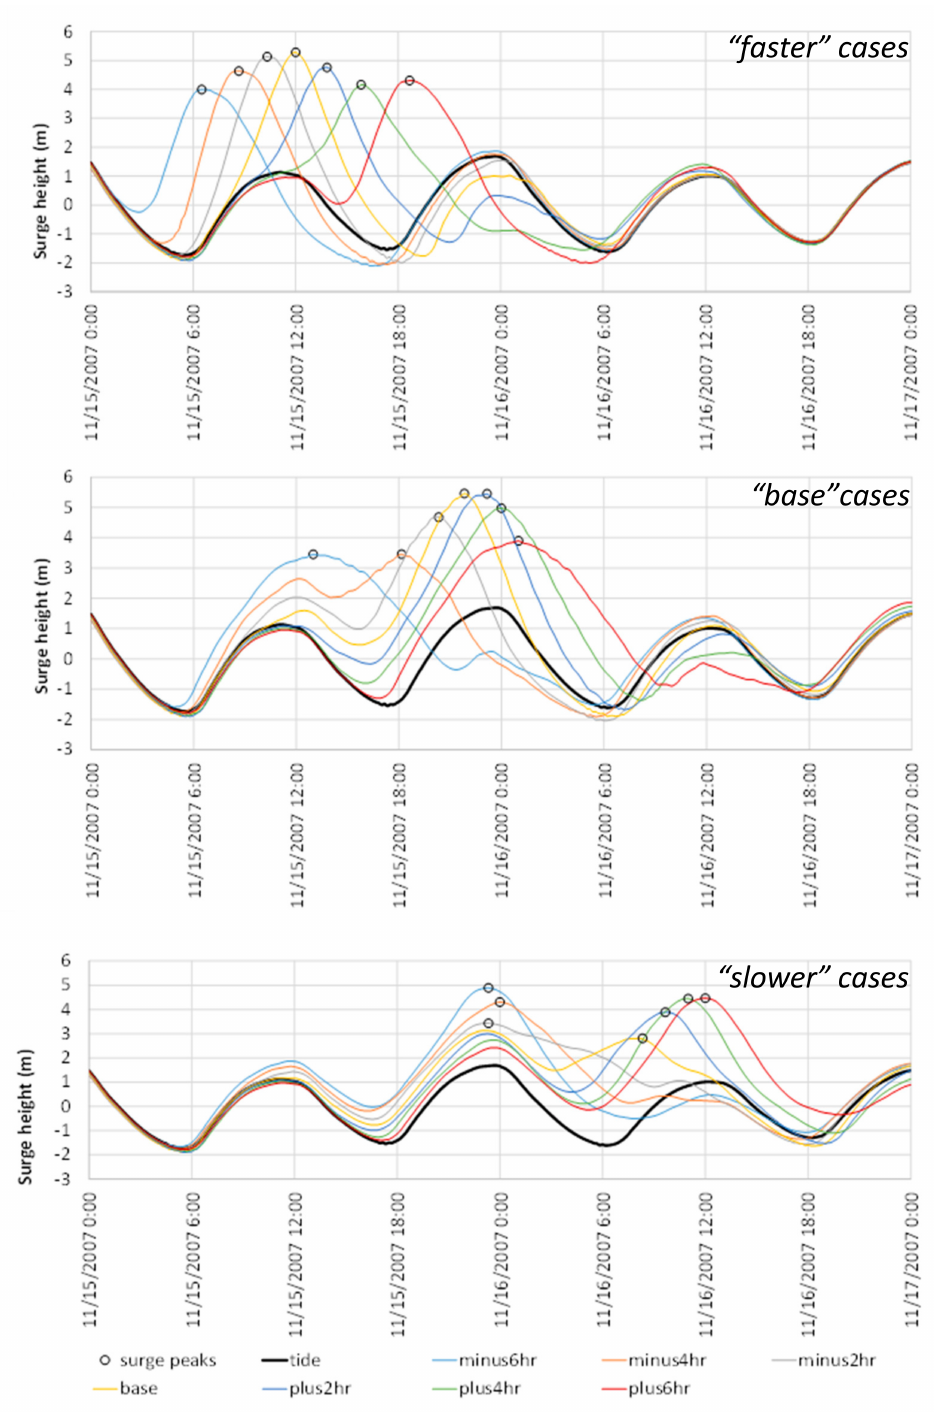
Figure 5. Computed tidal water levels, surge profiles and surge peaks at different tidal phases at Sitakunda for “faster” cases ( top panel ), “base” cases ( middle panel ) and “slower” cases ( bottom panel